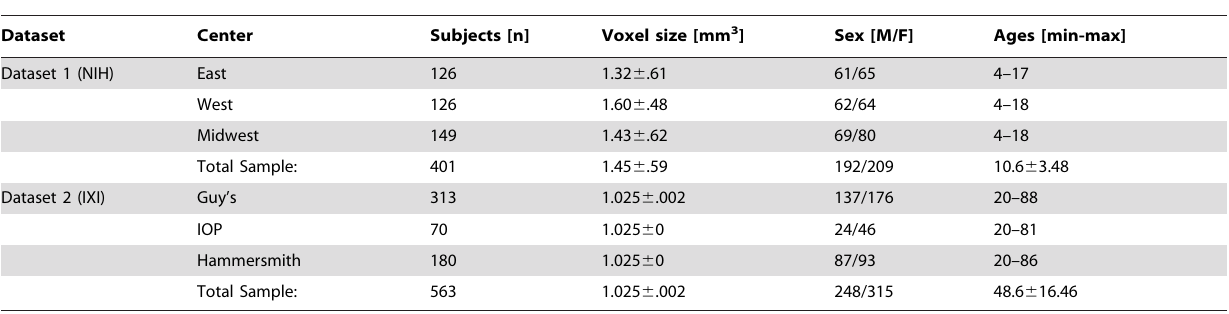
Table 1. Core characteristics of dataset 1 and 2 (structural MRI).